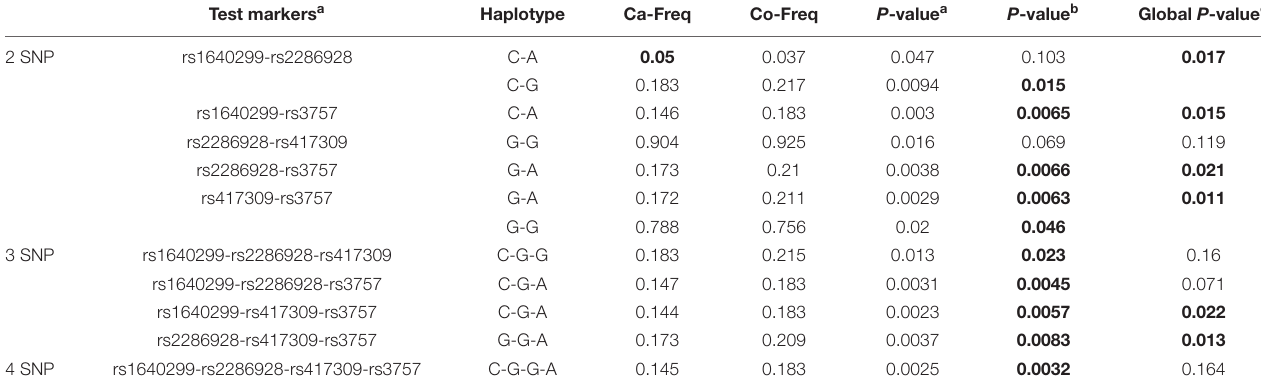
TABLE 2 | Estimated haplotype frequencies in the case-control